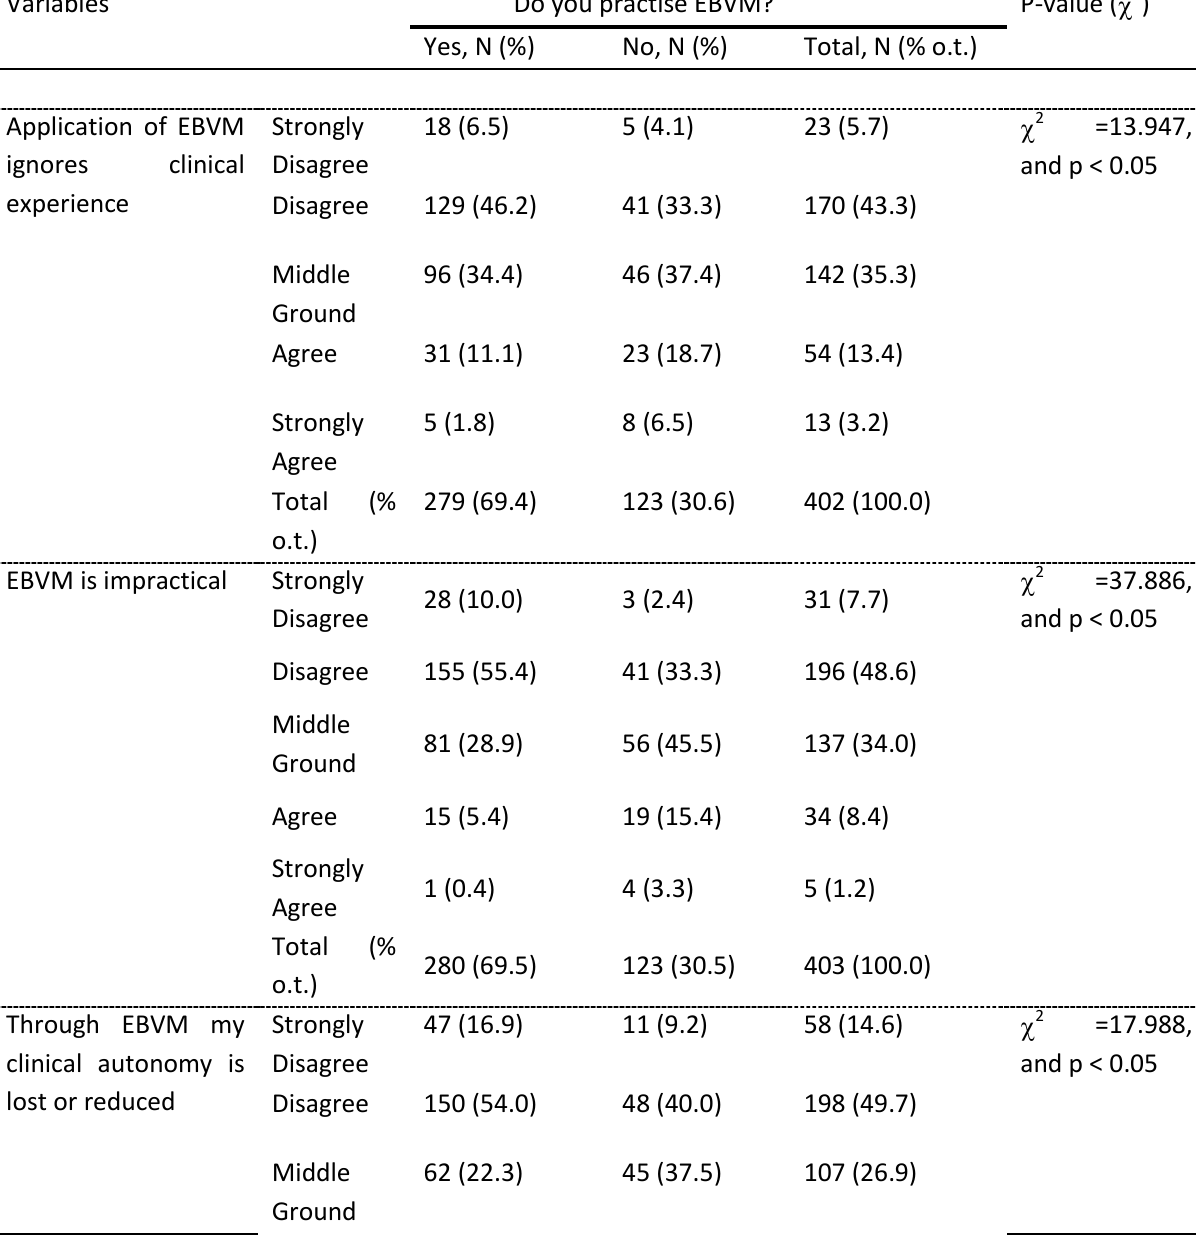
Table 10 : The barriers to EBVM III Variables Do you practise EBVM? P-value (  2 ) Yes, N (%) No, N (%) Total, N (%